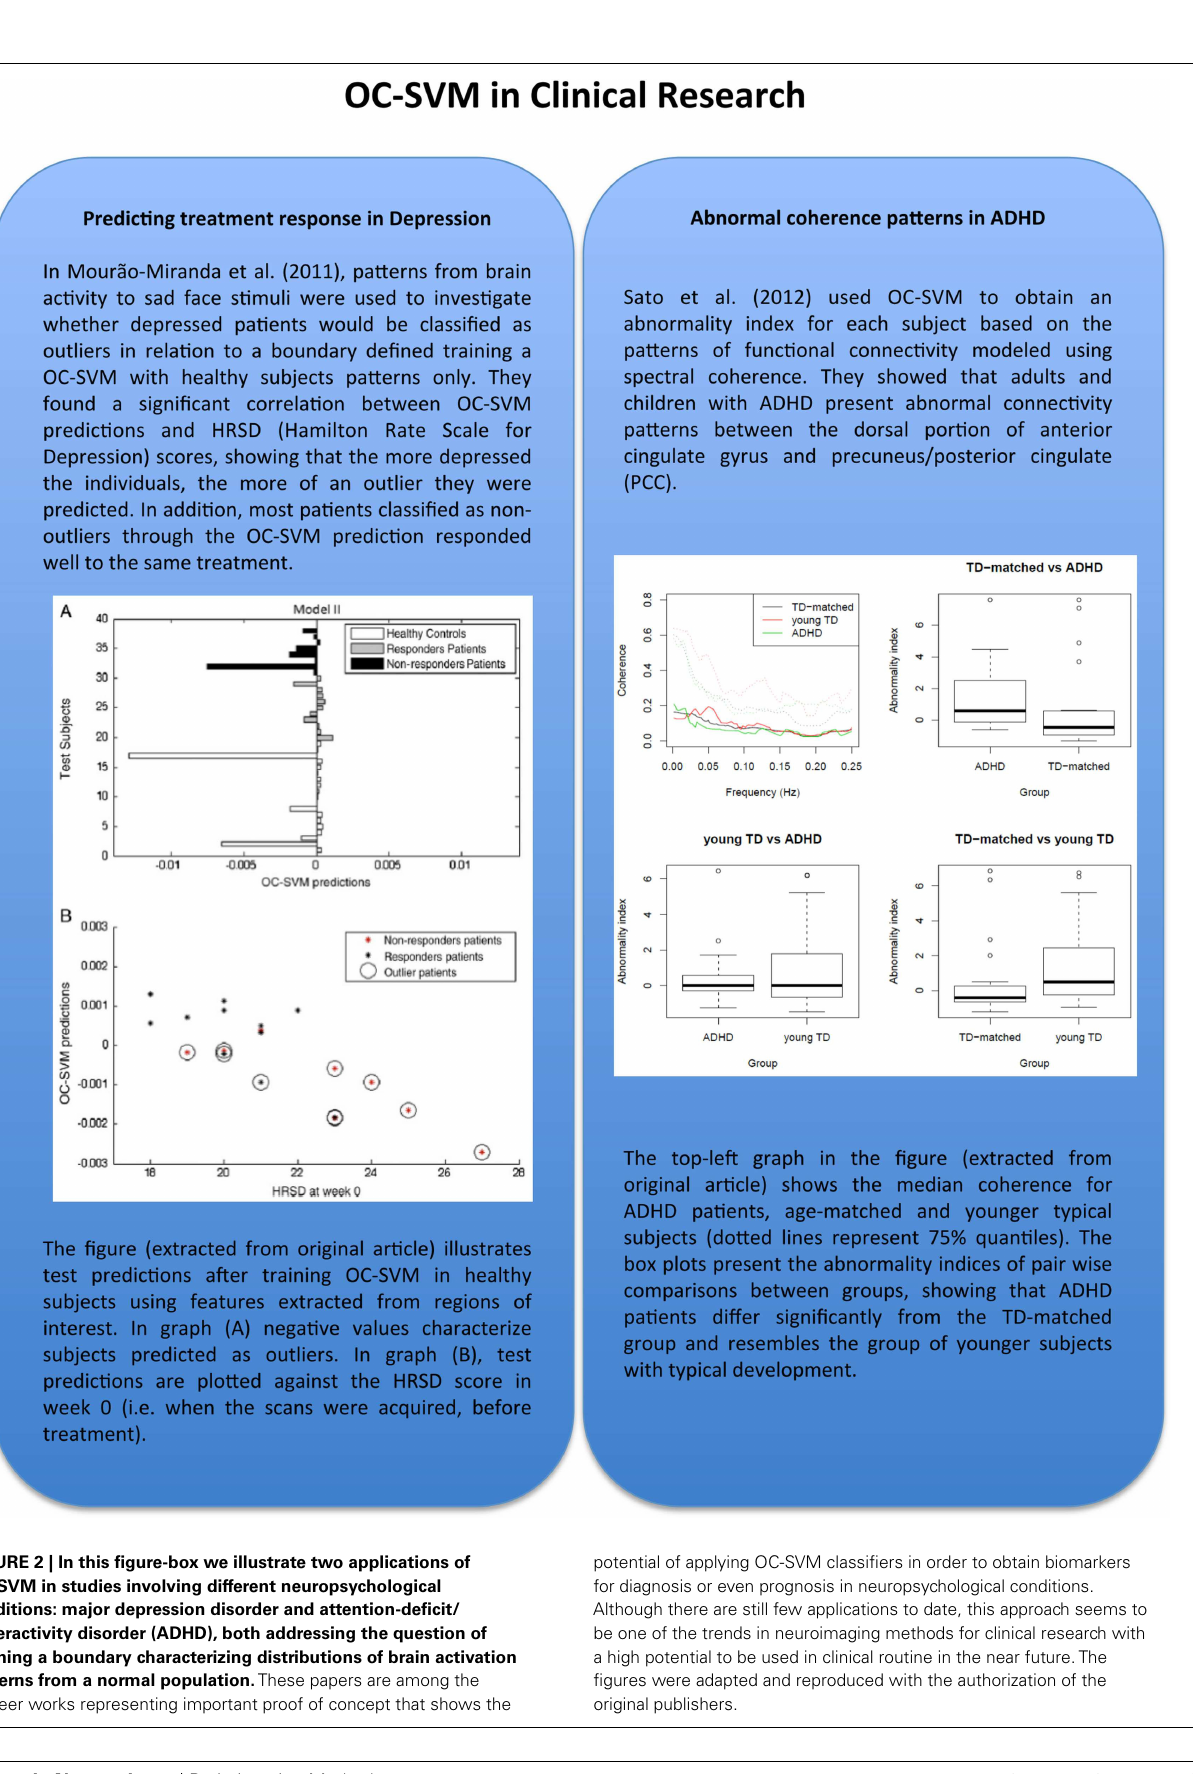
potential of applying OC-SVM classifiers in order to obtain biomarkers for diagnosis or even prognosis in neuropsychological conditions. Although there are still few applications to date, this approach seems to be one of the trends in neuroimaging methods for clinical research with a high potential to be used in clinical routine in the near future.The figures were adapted and reproduced with the authorization of the original